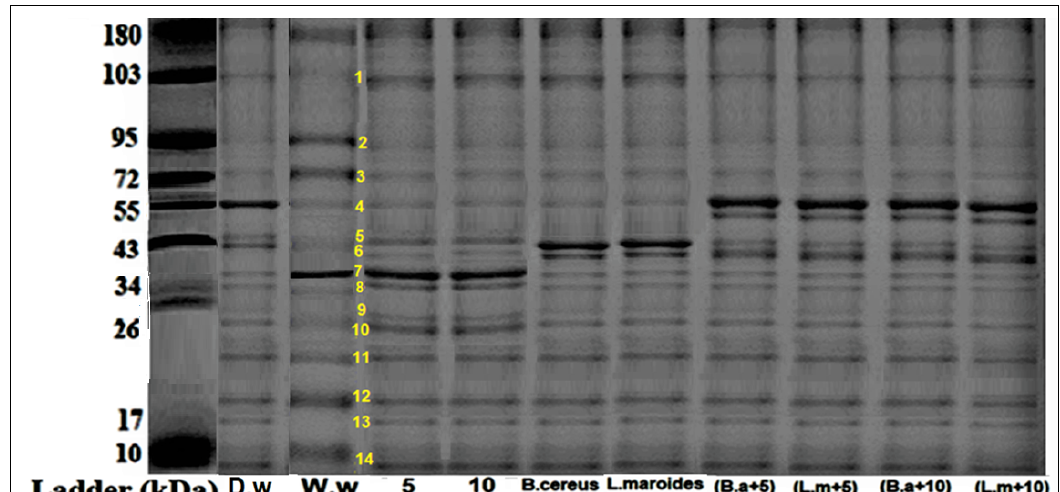
Figure 2. Protein banding intensity of rice plants that were grown by the synergistic treatment of seeds that were primed with bacteria and grown in ZnO NPs alone or in combination with distilled water at marker size (34, 43, 55, and 72 kDa).